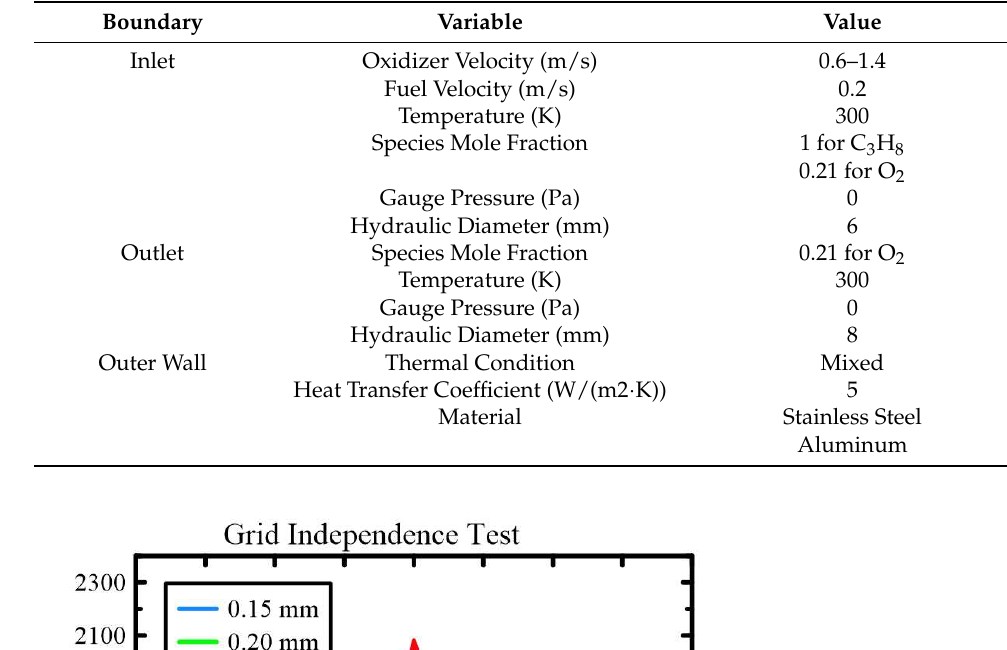
Table 1. Boundary Condition Details.